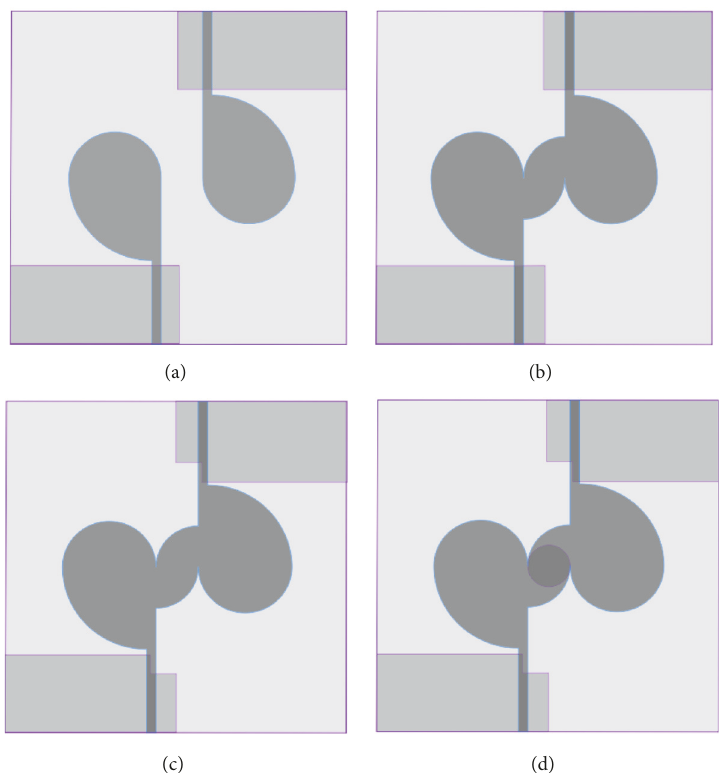
Figure 2: Geometry of the proposed UWB antenna with different evolution steps. (a) Without the connecting radiation patch, (b) with the connecting radiation patch, (c) with the ground plane etched, and (d) with the parasitic